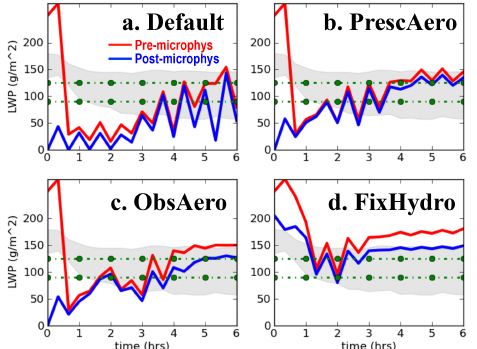
Figure 2. Time series of LWP before and after microphysics for DYCOMS RF02. The shaded area indicates the range of LES values averaged over the last 4h of the simulation period from Stevens and Seifert (2008) and the area bounded by dots indicates the range of observational uncertainty from Stevens et al. (2003).